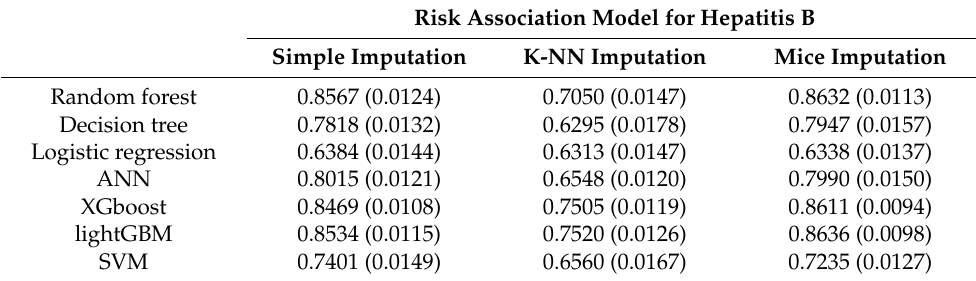
Table 5. Average AUC values for each combination of the hepatitis B prediction model and missing value imputer. Standard deviation is calculated in the parentheses.